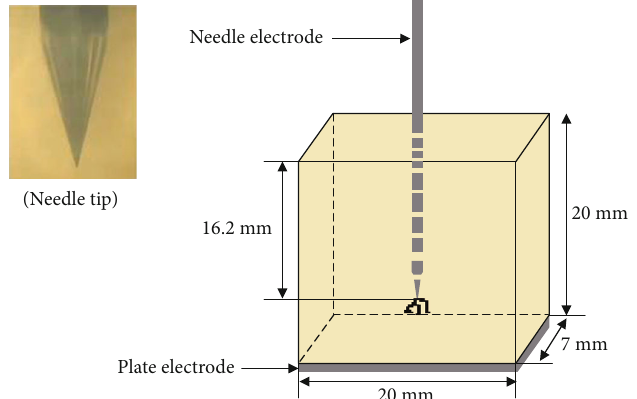
Figure 2: Arrangement of needle-plate electrodes for treeing test.